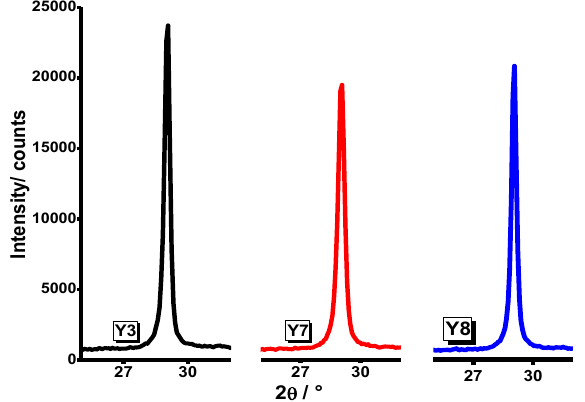
Figure 4. XRD pattern of Y 2 O 3 powder synthesized from yttrium nitrate in the presence and absence of P-123 poloxamer heat-treated at 900 °C for 1 h.